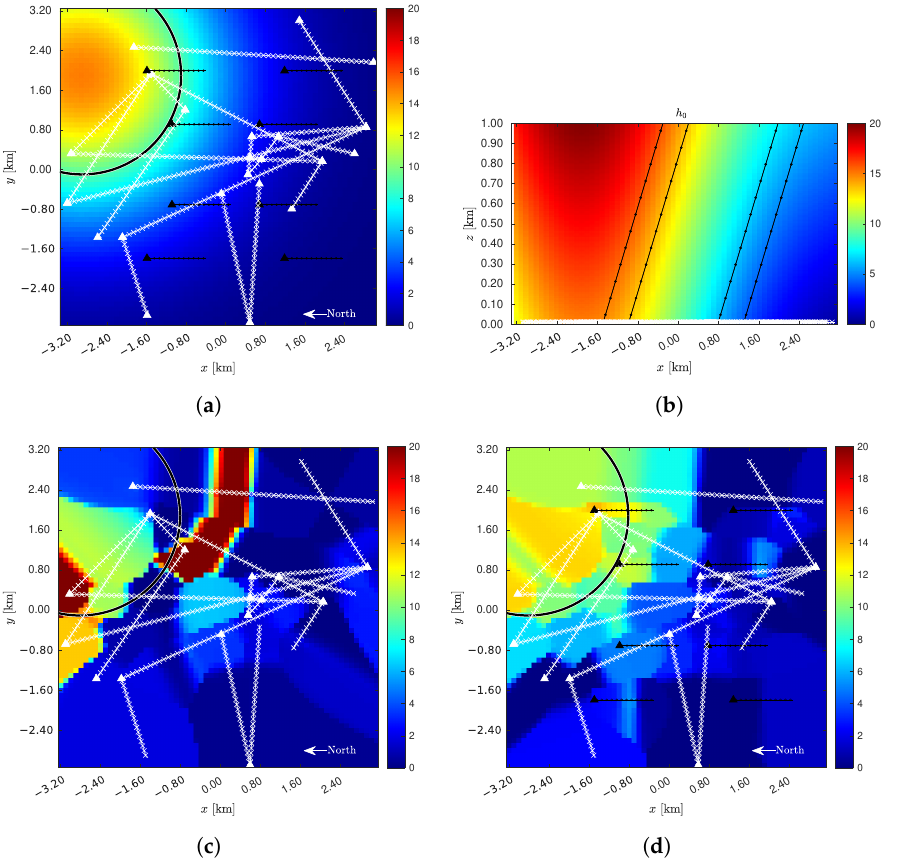
Figure 4. Rainfall rate estimation for a single realization with R = 15 mm/h and g alg = g G = 5 mm/h/km. ( a ) ¯ r ( C ) : π H ( 0 ) plane. ( b ) ¯ r ( C ) : π V ( y G ) plane. ( c ) r ( C ) : N CML = 21, N BSL = 0, ε RMS = 5.715, ρ = 0.470. ( d ) r ( C ) : N CML = 21, N BSL = 8, ε RMS = 1.981, ρ =